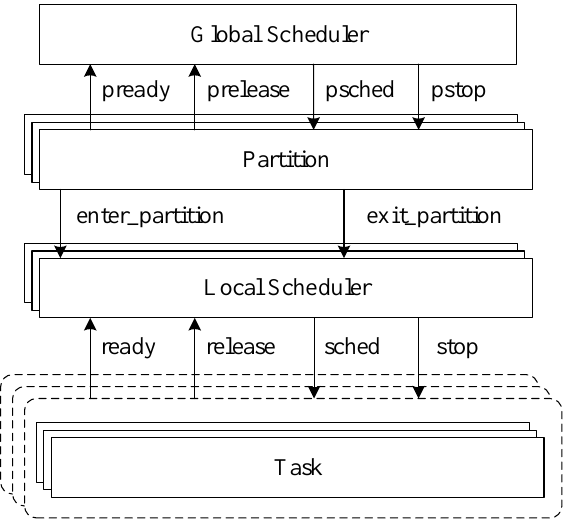
Figure 3. Timed automata (TA) modeling framework of IMA partition scheduling